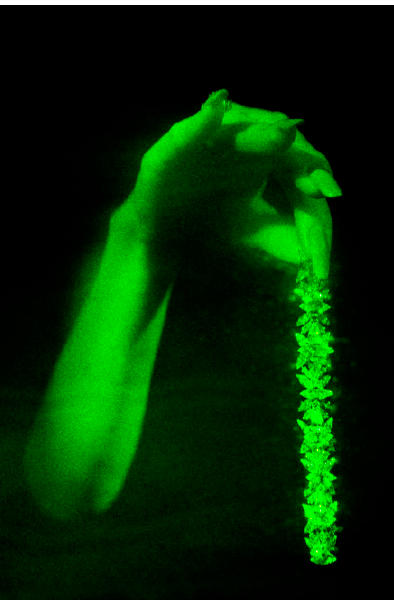
Figure 5. Pulsed-laser hologram made for Cartier window display, 1972. (Photo credit: MIT Museum, gift of Marian B. Javits, photo by Barry Heatherington.)